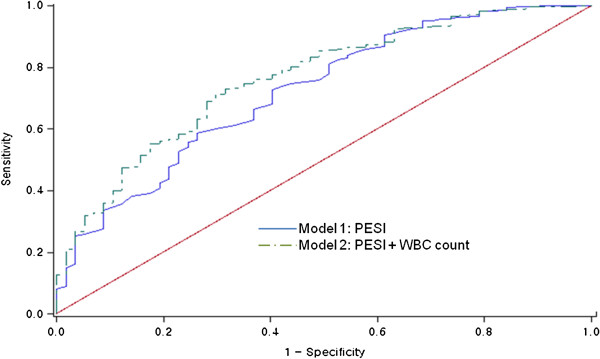
Receiver operating characteristic curves for the 30-day mortality. The curves are based on logistic regression models for risk prediction, incorporating the following: Model 1, PESI (AUC = 0.72; 95% CI, 0.68–0.75); PESI + WBC count (AUC = 0.76; 95% CI, 0.72–0.79), P = 0.008 versus Model 1. PESI: pulmonary embolism severity index; AUC: area under the receiver operating characteristic curve; CI: confidence interval; WBC: white blood cell.